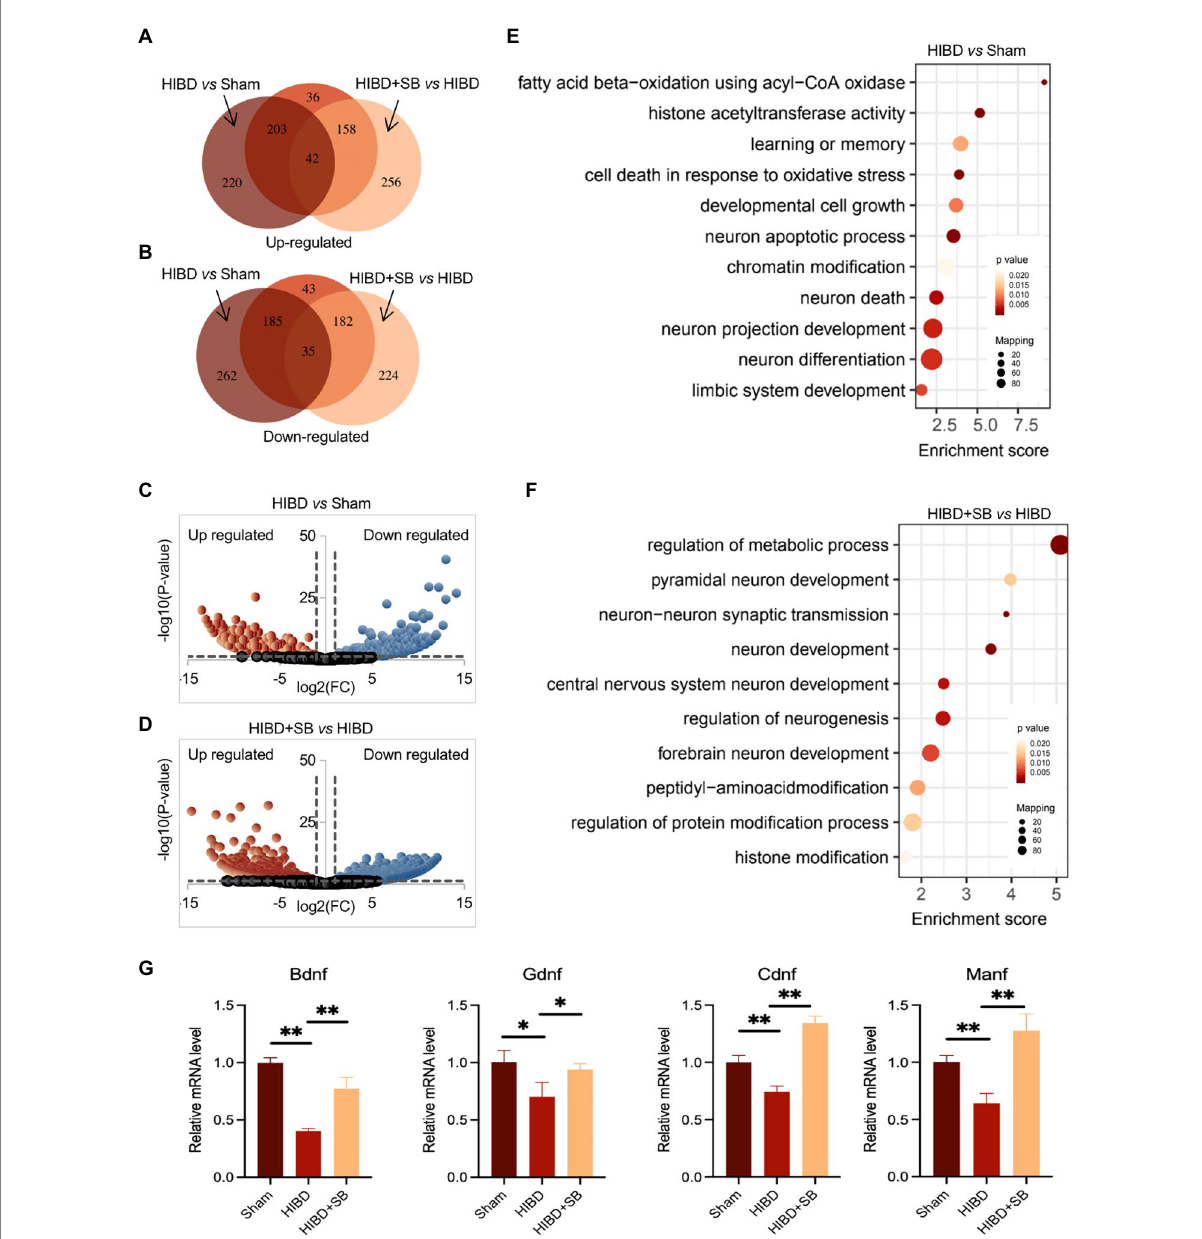
FIGURE 7 The total RNA was analyzed using RNA-seq. Identified-differential expression genes in Sham, HIBD and HIBD + SB group, which were shown by Venn ( A,B ) and volcano diagram ( C,D ). ( E,F ) The GO terms and corresponding enrichment p values in three groups. ( G ) HIE-related neurotrophic factor genes Bdnf , Gdnf , Cdnf and Manf mRNA extracted from the brain in three groups were assessed by RT-qPCR. GAPDH was used as control. * p < 0.05, ** p < 0.01, n = 3, error bars represent